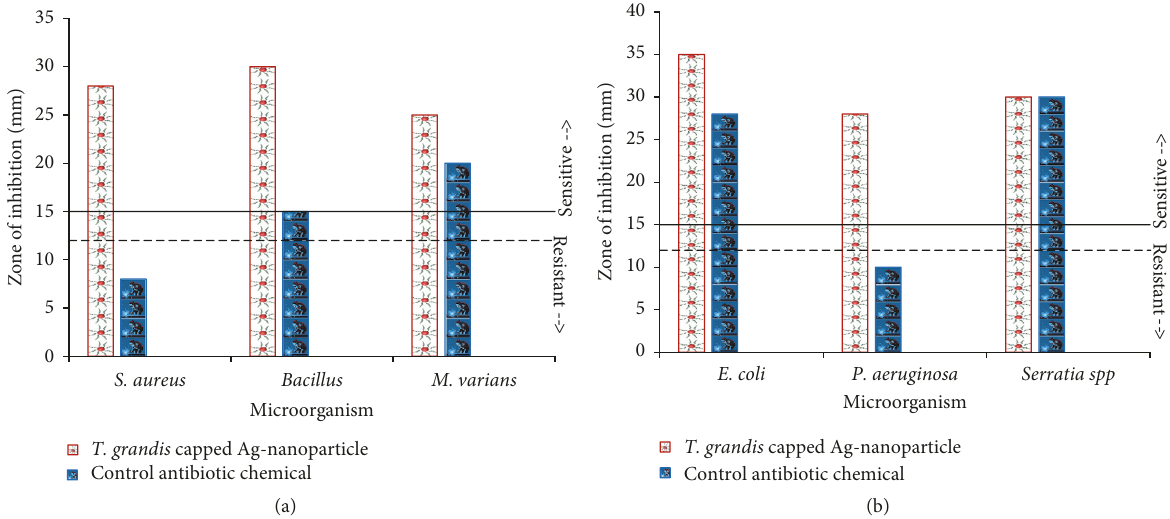
Figure 3: Growth inhibition effects by T. grandis capped silver-nanoparticle material on MIC inducing microbial strains. (a) Gram-positive microbial strains. (b) Gram-negative microbial